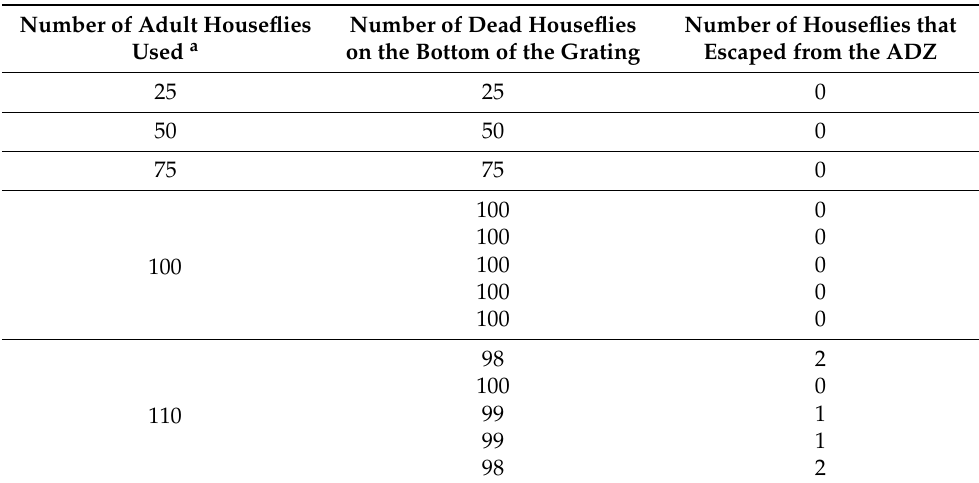
Table 3. Evaluation of the capability of the arc discharge zapper (ADZ) used to control successive invasions of adult houseflies. Number of Adult Houseflies Number of Dead Houseflies Number of Houseflies that Used a on the Bottom of the Grating Escaped from the